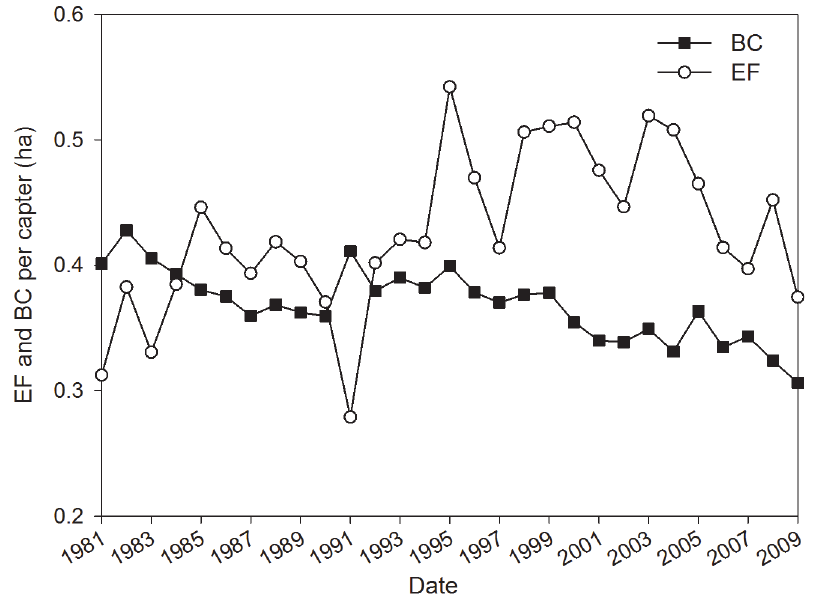
Fig 4. The conventional ecological footprint (EF) and biocapacity (BC) per capita for cropland in Yuanzhou County, Ningxia Hui Autonomous Region, China during the period 1981 – 2009.